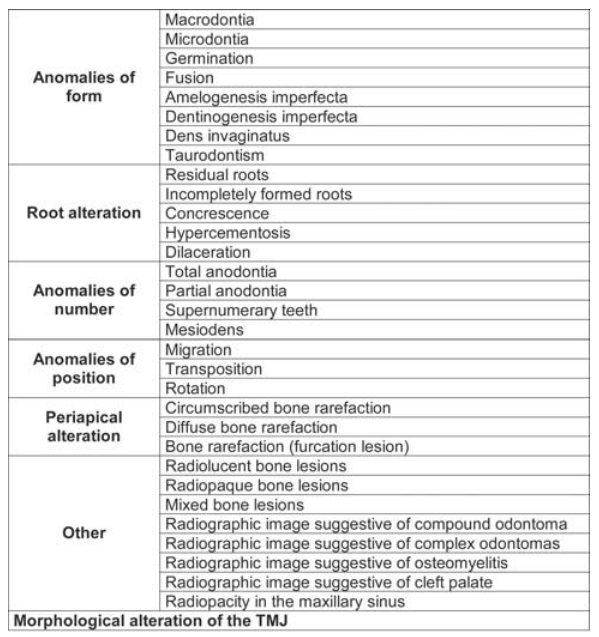
FIGURE 2- Analysis of dental and maxillomandibular alterations